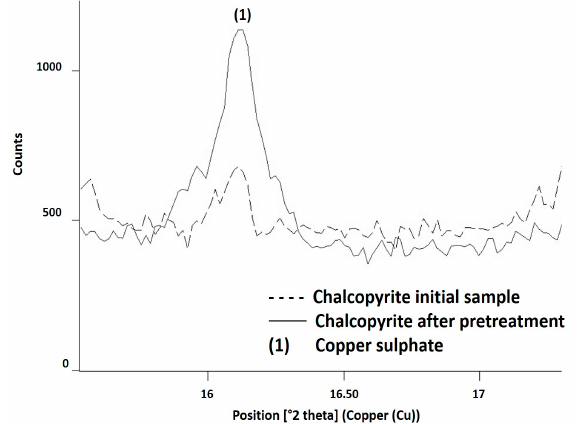
Figure 8. Identification of CuSO 4 by X-ray diffraction analysis in chalcopyrite pretreated with 15 kg/t of H 2 SO 4 , 25 kg/t of NaCl, and 15 days of curing at room temperature.